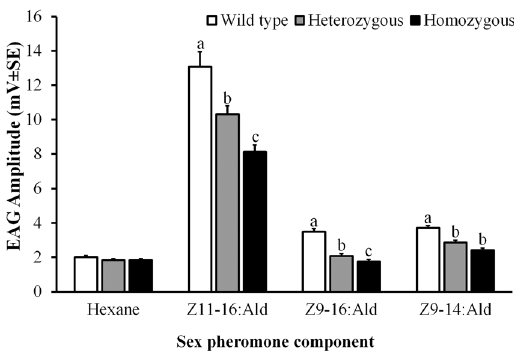
Figure 4. The EAG responses of wide type (n = 6), heterozygous (n = 11) and homozygous (n = 8) male adults to the three sex pheromone components. The 3-day old virgin males were tested against pheromone dose of 500 ng/filter. Error bars represent standard error (SEM). EAG values among the 3 types of males were compaired by one-way ANOVA followed with least-significant difference test (LSD). Different letters indicate significant differences at p <